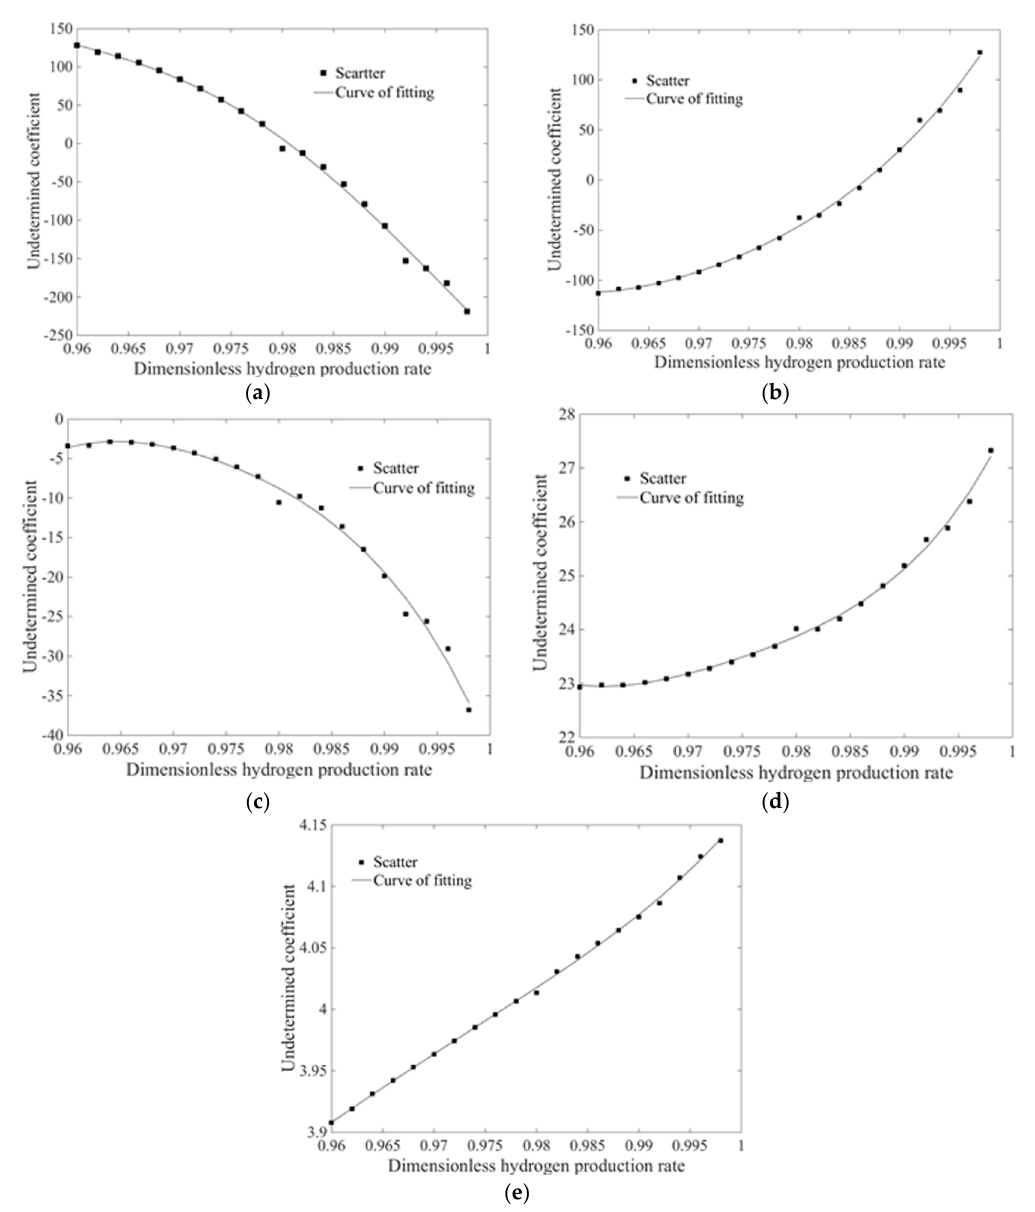
Figure 10. ( a ) The scatter plot of α and p ( 1 ) and the curve of function f 1 ( α ) ; ( b ) the scatter plot of α and p ( 2 ) and the curve of function f 2 ( α ) ; ( c ) the scatter plot of α and p ( 3 ) and the curve of function f 3 ( α ) ; ( d ) the scatter plot of α and p ( 4 ) and the curve of function f 4 ( α ) ; ( e ) the scatter plot of α and p ( 5 ) and the curve of function f 5 ( α )